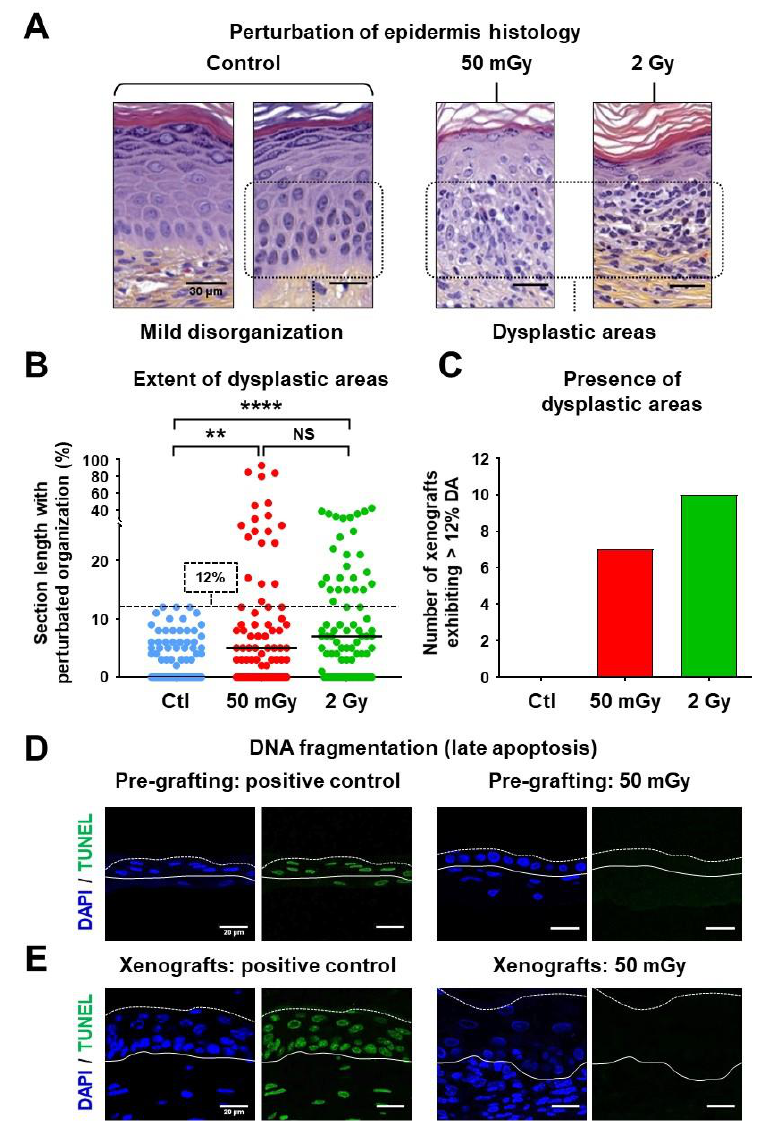
Figure 2. Local dysplastic areas developed in xenografted epidermises originating from irradiated keratinocyte precursors. ( A ) HES coloration of human skin samples 20 days post-xenografting. Representative pictures were selected for the visualization of the normal histology of control epidermises, the mild disorganization considered as the background of the xenograft model, and examples of dysplastic areas (DA) that were characteristic of irradiated conditions. ( B ) Estimation of the percentage of tissue section length displaying mild disorganization or DA. A total of 14 xenografts were performed for the control (Ctl) and 50 mGy conditions, and 13 were performed for the 2 Gy condition. Dot plots cumulated the analyses of 6 sections for each xenograft. Bars correspond to median values (NS p > 0.05; ** p < 0.01; **** p < 0.0001, Mann–Whitney U test). ( C ) The histogram shows the numbers of xenografts that